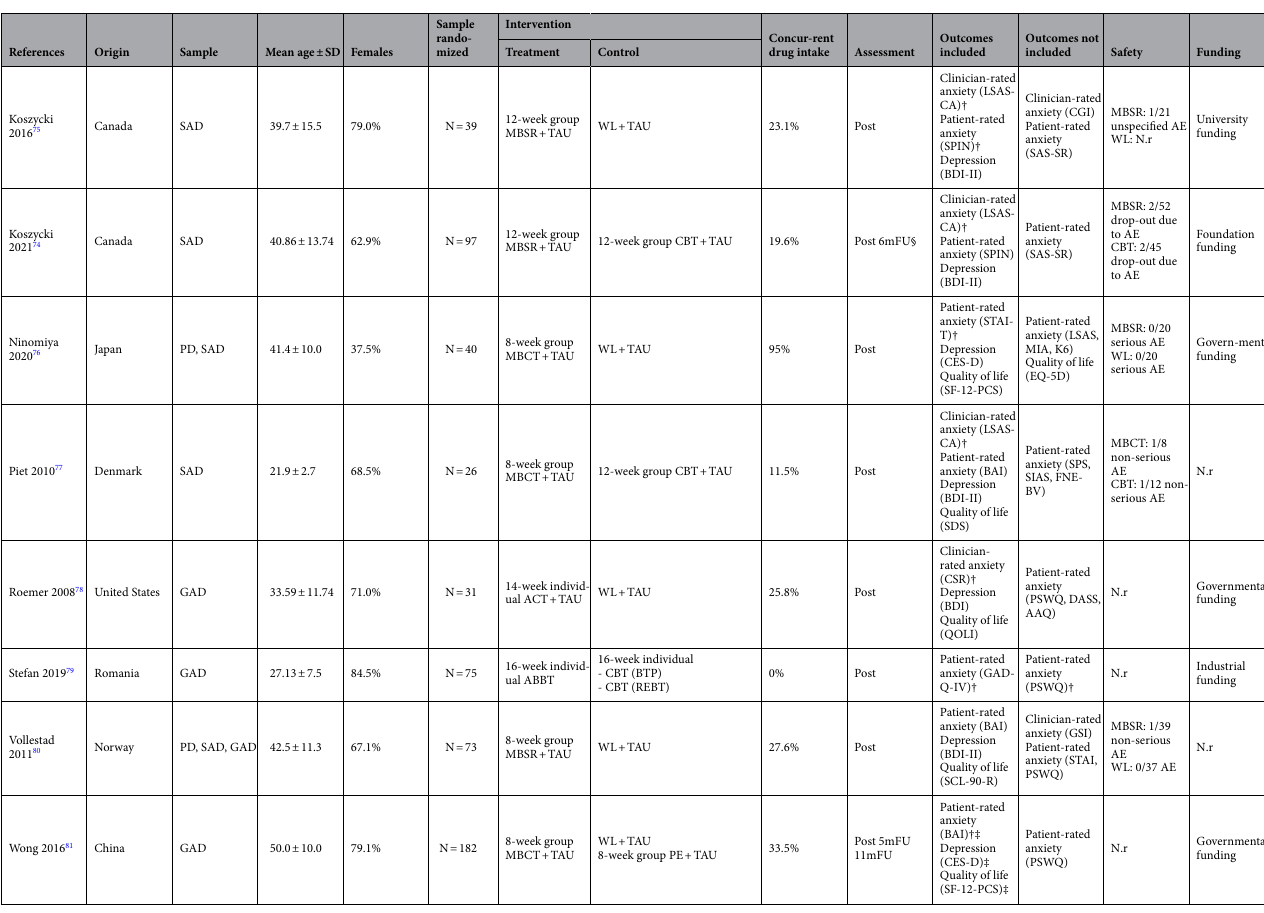
Table 2. Characteristics of the included studies. AAQ-II = Acceptance and Action in Social Anxiety Questionnaire; ABBT = Acceptance-based Behavioral Therapy; ACQ = Agoraphobic Cognitions Questionnaire; ADIS: Anxiety Disorder interview Schedule; ADNOS = Anxiety Disorder Not Otherwise Specified; AP = Agoraphobia; AR = Applied Relaxation; ASI = Anxiety Sensitivity Index; BAI = Beck Anxiety Inventory; BAFT = Believability in Anxious Feelings and Thoughts Questionnaire; BDI-II = Beck Depression Inventory-II; BSQ = Bodily Sensations Questionnaire; CBT (BTP/REBT) = Cognitive Behavioral Therapy (Borkovec’s treatment package / Rational Emotive Behavior Therapy according to Ellis); CES-D = Centre for Epidemiological Studies-Depression Scale; CGI = Clinical Global Impression Severity Scale; CSR = Clinician Severity Ratings; DASS = Depression Anxiety and Stress Scale; EQ-5D = EuroQol 5-Dimension; FNE-BV = Fear of Negative Evaluation-Brief Version; GAD = Generalized Anxiety Disorder; GAD-Q-IV = Generalized Anxiety Disorder Questionnaire-IV; HAM-A = Hamilton Anxiety Rating Scale; IPSM = Interpersonal Sensitivity Measure; K6 = 6-item Psychological Distress Scale; LSAS-SR/CA = Liebowitz Social Anxiety Scale-Self Report/ Clinician Administrated; LSRDS = Liebowitz Self-Rated Disability Scale; MADRS = Montgomery-Åsberg Depression Rating Scale; MBCT = Mindfulness Based Cognitive Therapy; MBSR = Mindfulness Based Stress Reduction; MCQ-30 = Metacognitions Questionnaire; MDD = Major Depressive Disorder; mFU = months after start of study; MIA = Mobility Inventory for Agoraphobia; N = sample size; N.r. = not reported; OQ-45 = 45-item Outcome Questionnaire; PAS = Panic Agoraphobia Scale; PD = Panic Disorder; PDSS-SR = Panic Disorder Severity Scale Self-Rated; PE: Psychoeducation; PHQ-9 = Patient Health Questionnaire; QOLI = Quality of Life Index; RRS = Ruminative Response Scale; RRQ = Rumination-Reflection Questionnaire; SAD = Social Anxiety Disorder; SAFE = Subtle Avoidance Frequency Examination; SAS-SR = Social Adjustment Scale Self- Report; SCL-90-R = Symptom Checklist-90-R; SDS = Shehan Disability Scale; SF-12-PCS = Short-Form Health Survey-Physical Component Score; SIAS = Social Interaction Anxiety Scale; SPIN = Social Phobia Inventory; SPS = Social Phobia Scale; STAI-T = State-Trait Anxiety Inventory-Trait Anxiety Subscale; TAU = treatment as usual; WHOQOL = World Health Organization Quality of Life Questionnaire; WL = wait-list; † = primary outcome(s) of the study; ‡ = data not published but provided by trial authors upon request; § = data not published & not provided by trial authors upon